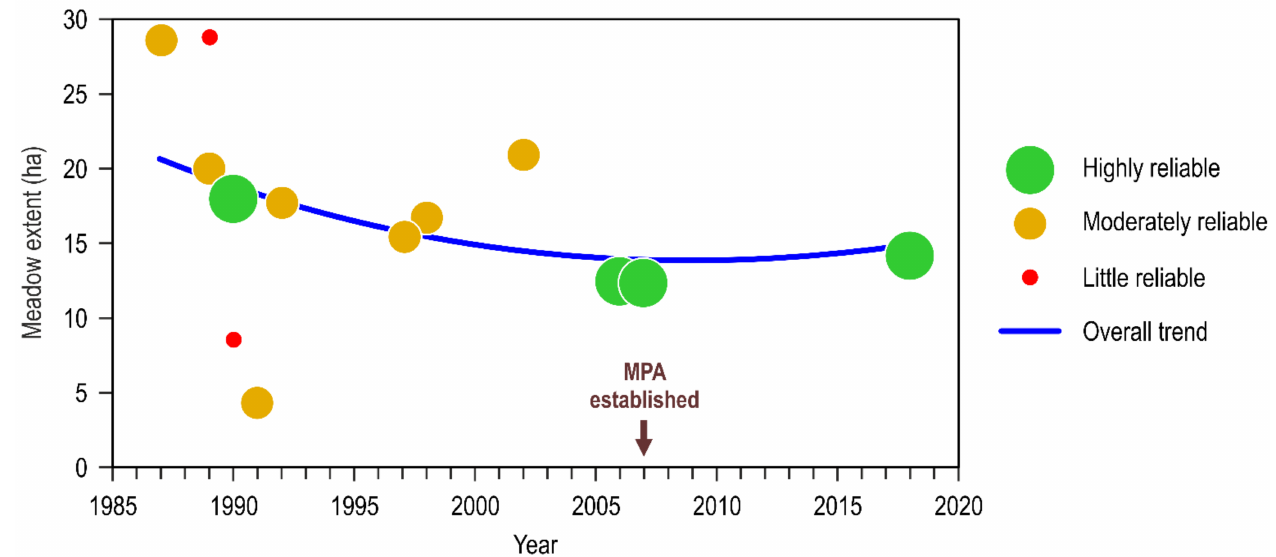
Figure 4. Change of Posidonia oceanica cover in the Marine Protected Area of Bergeggi (Ligurian Sea, NW Italy) between 1987 and 2018 (based on information in [116,126,145]). Data are classified according to their reliability (see